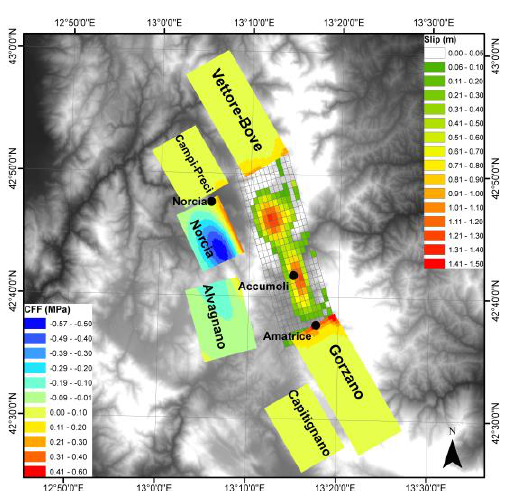
Figure 4. CFF computations on the known faults nearby the Amatrice fault. The stress variations are due to the mainfault slip